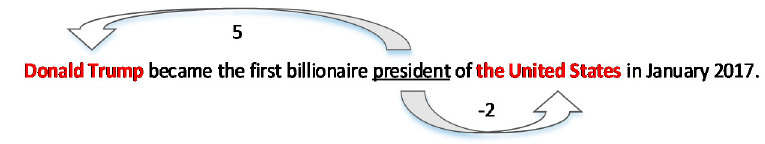
Figure 2. An example of position embedding.